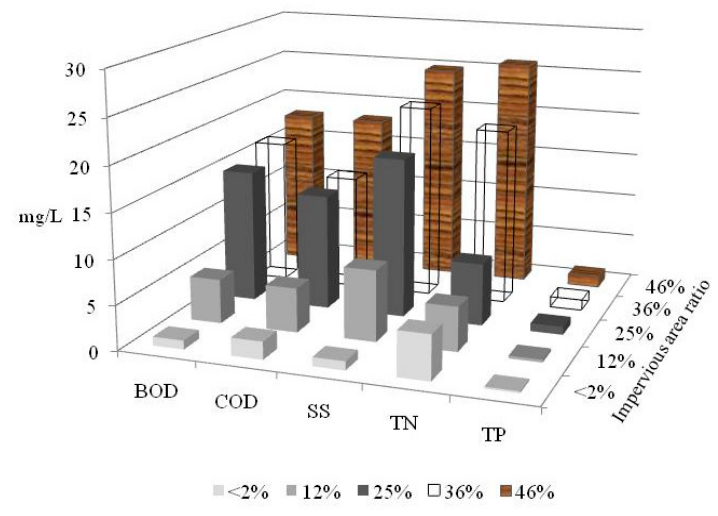
Figure 4. Water quality of the watershed by impervious area.